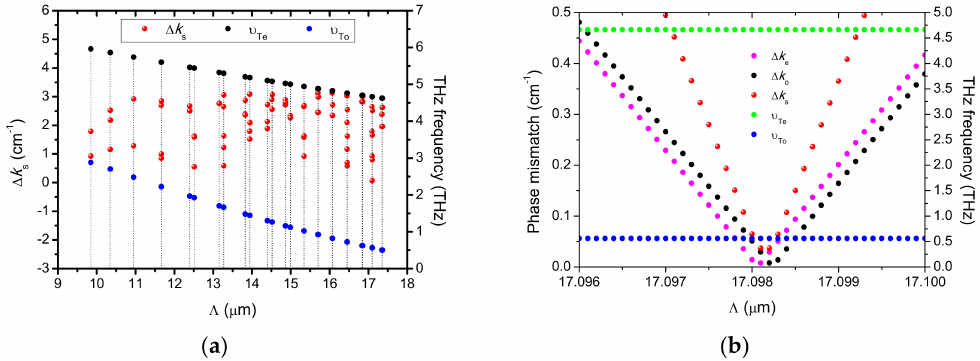
Figure 3. The phase-matching characteristics for the forward SPS processes. ν Te and ν To are the frequencies of the THz e and THz o waves, respectively. The sum phase mismatch ∆ k s = and λ p = 1550 nm. ( a ) The phase-matching characteristics with Λ from 9 to 18 µ m. ( b ) The detailed phase-matching characteristics with Λ from 17.096 to 17.100 µ